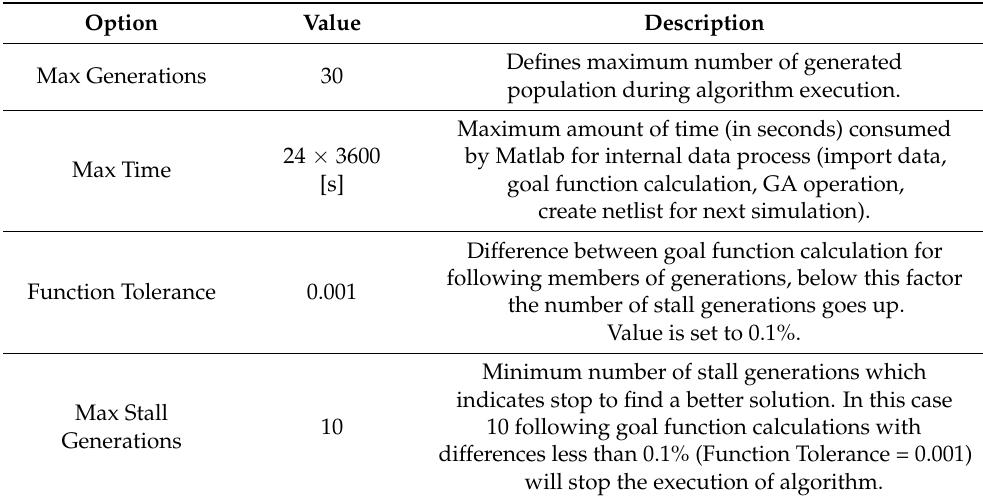
Table 3. Stopping criteria